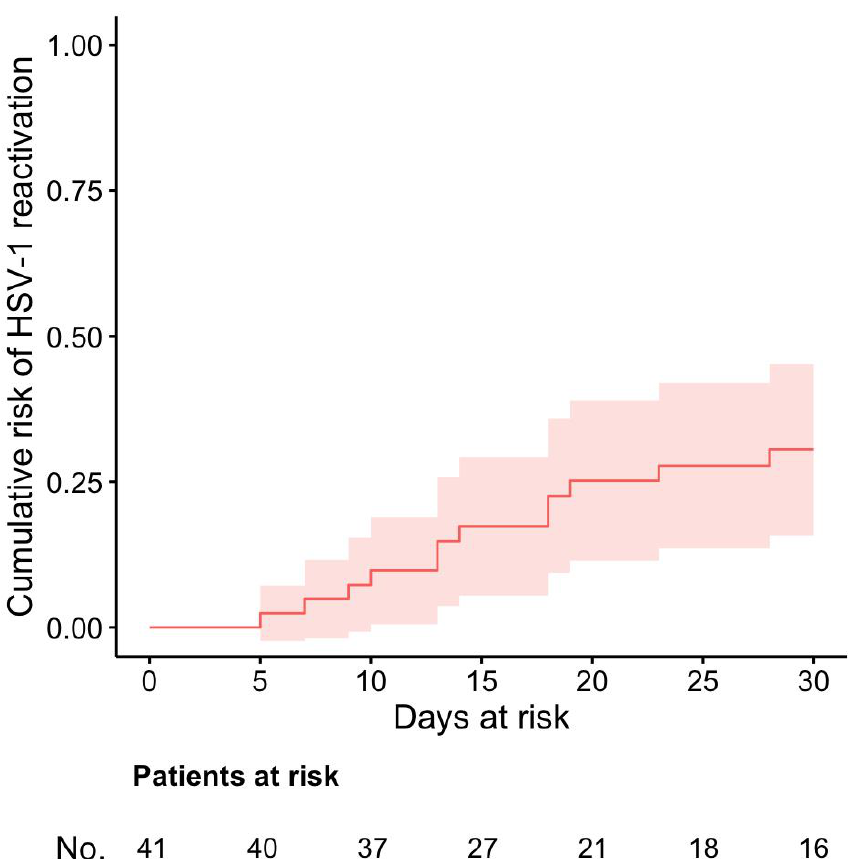
Figure 1. Cumulative risk of HSV-1 reactivation in the study population, estimated by means of the Aalen–Johansen method, with HSV-1 reactivation as the event of interest, discharge from the intensive care unit as a right-censoring event, and death as a competing event. The time of origin was the day of the initial negative molecular test for HSV-1-DNA on BALF samples.